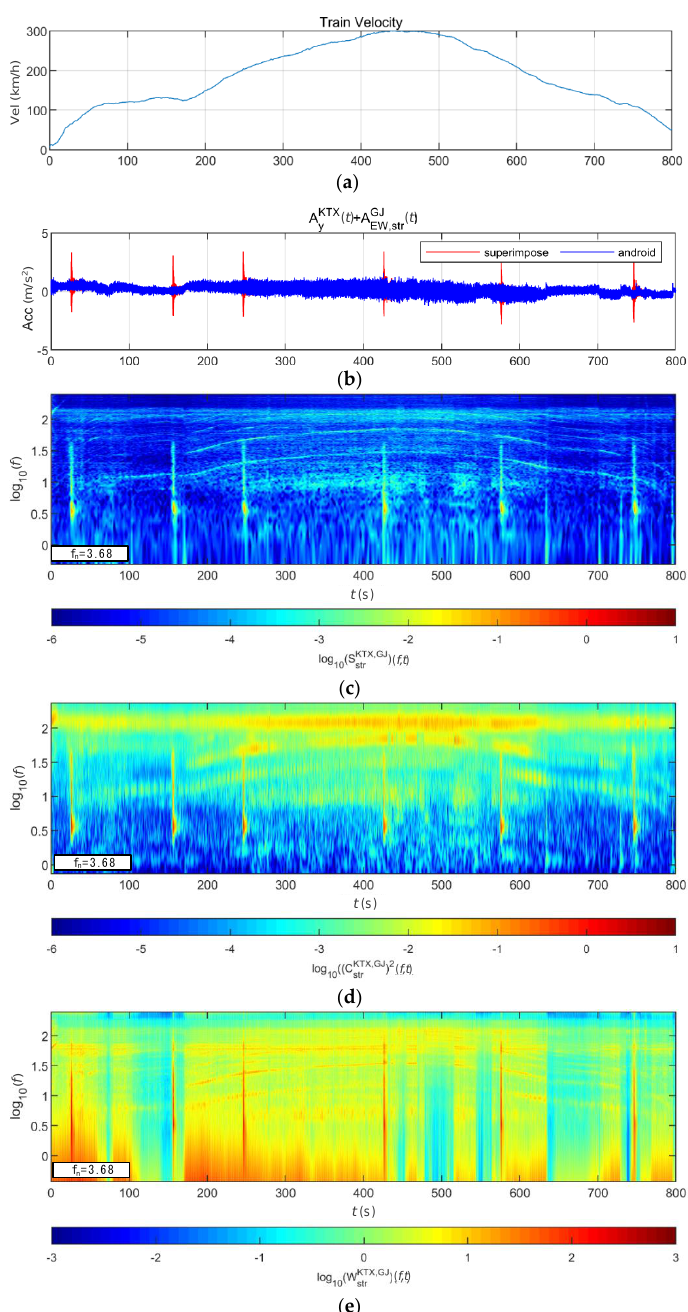
Figure 34. Combination of train data with BR3 bridge-response data from the Gyeongju earthquake (scaled to 1000-year return period): ( a ) velocity; ( b ) lateral acceleration time series; ( c ) STFT; ( d ) WT; ( e ) WVD.